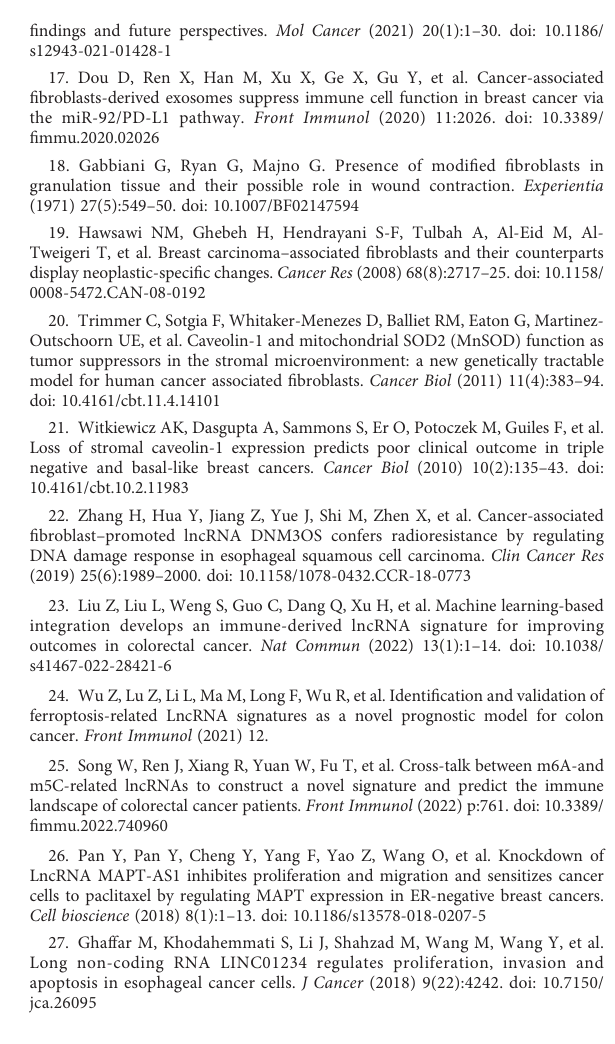
TABLE S2 Differentially expressed lncRNAs between fi broblasts and other cells. TABLE S3 Univariate Cox regression analysis of survival time of the 75 CAF- speci fi c lncRNAs. TABLE S4 Differentially expressed genes between the low- and high-risk groups. TABLE S5 Hallmark pathway enrichment of differentially expressed genes. TABLE S6 KEGG pathway enrichment of differentially expressed genes. TABLE S7 Inferred IC50 values of 198 drugs in patients with TCGA-BRCA gene expression pro fi